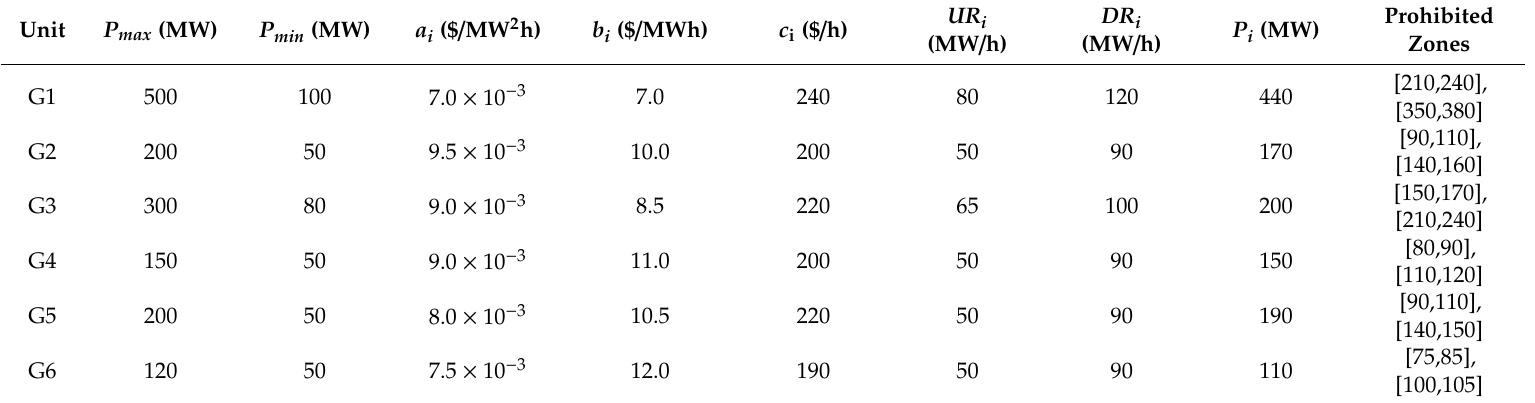
Table 4. The detailed generator unit data of System 1.